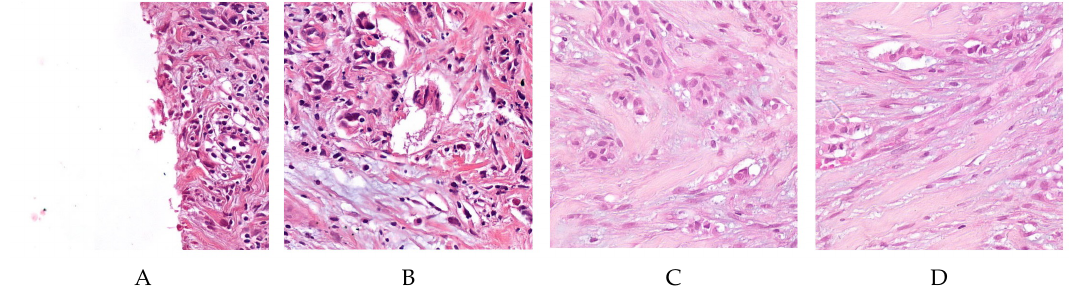
Figure 4. Tiles identified by the cancer classifier as: positive (first two tiles, tile ( A ) is a true positive, tile ( B ) is a false positive), and negative (last two tiles, tile ( C ) is a true negative, tile ( D ) is a false negative).